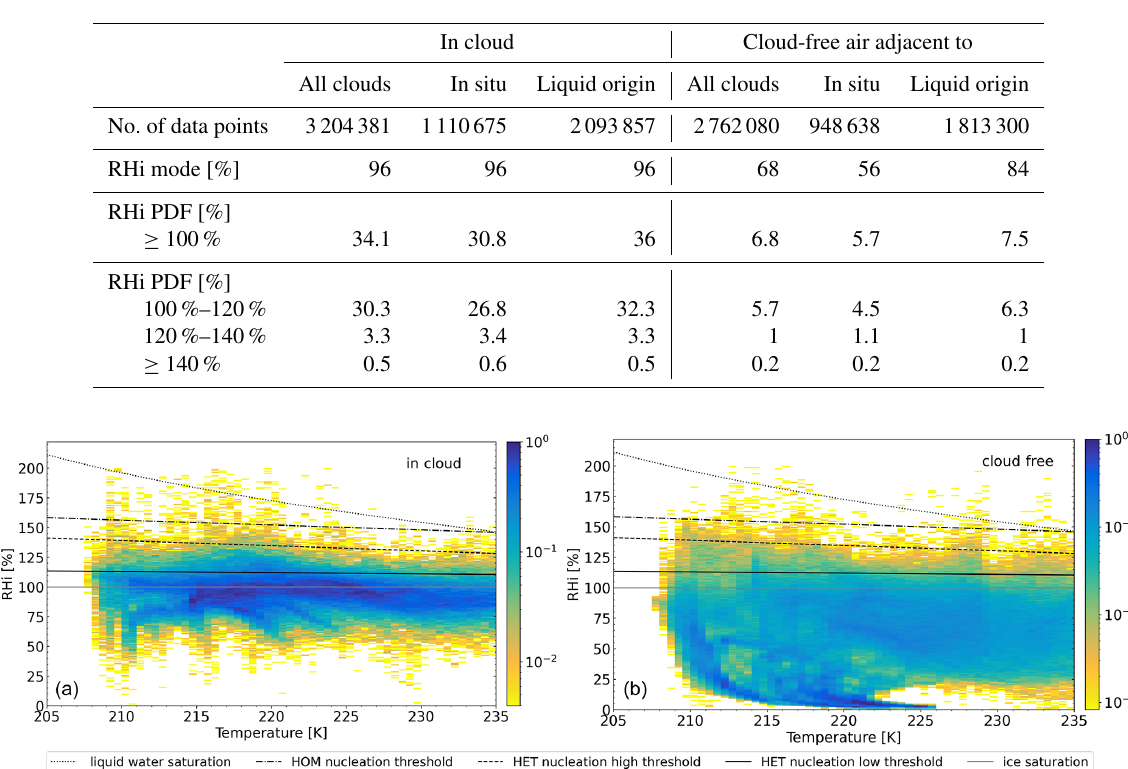
Table 2. Results from the analysis of the probability density functions (PDFs) of RHi. RHi mode: most common value of the dataset.